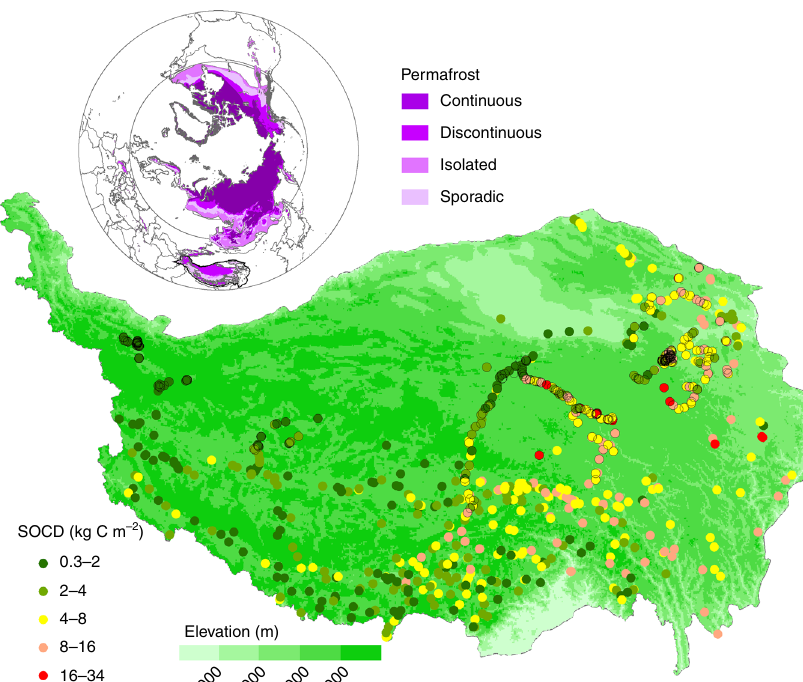
Fig. 1 The locations and soil organic carbon density (SOCD) of the top 30 cm layer for the 1114 sampling sites over the permafrost regions on the Tibetan Plateau. The deep soil carbon measurements (at a depth of more than 2 m) are indicated by black outlines for the coloured dots. The modern permafrost map was obtained from the National Snow & Ice Data Center